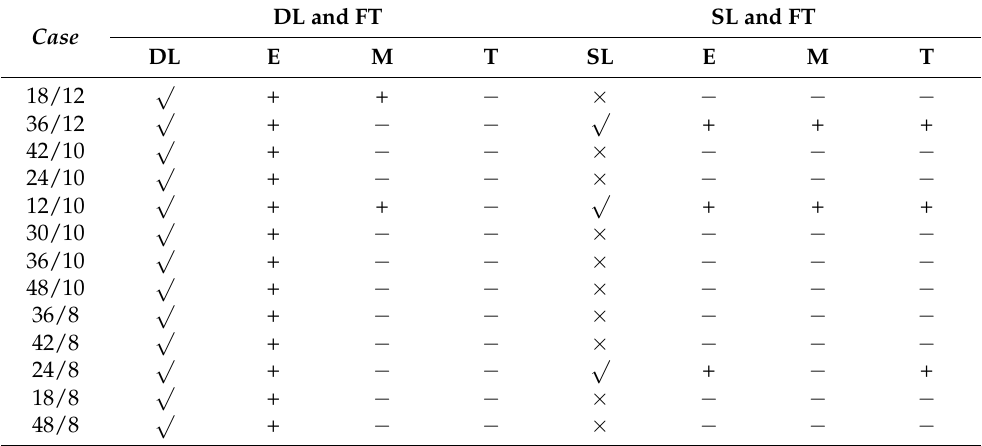
Table 5. DL/SL feasibility and fault tolerance (FT) of dual three-phase winding.